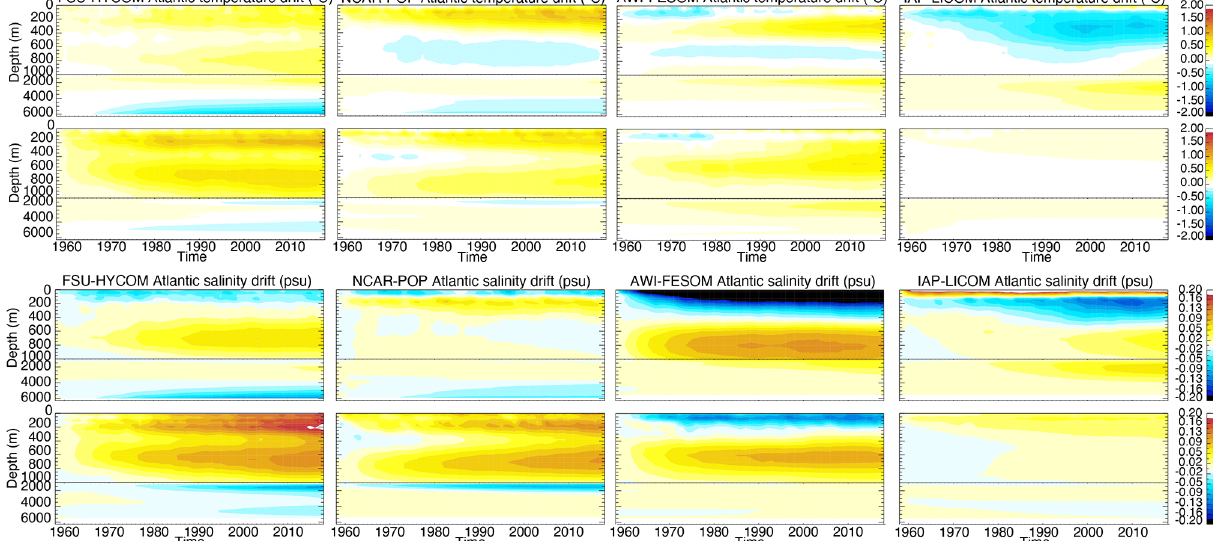
Figure 7. Time evolution of Atlantic Ocean temperature ( ◦ C) and salinity (psu) change (relative to initial conditions) as a function of depth for all